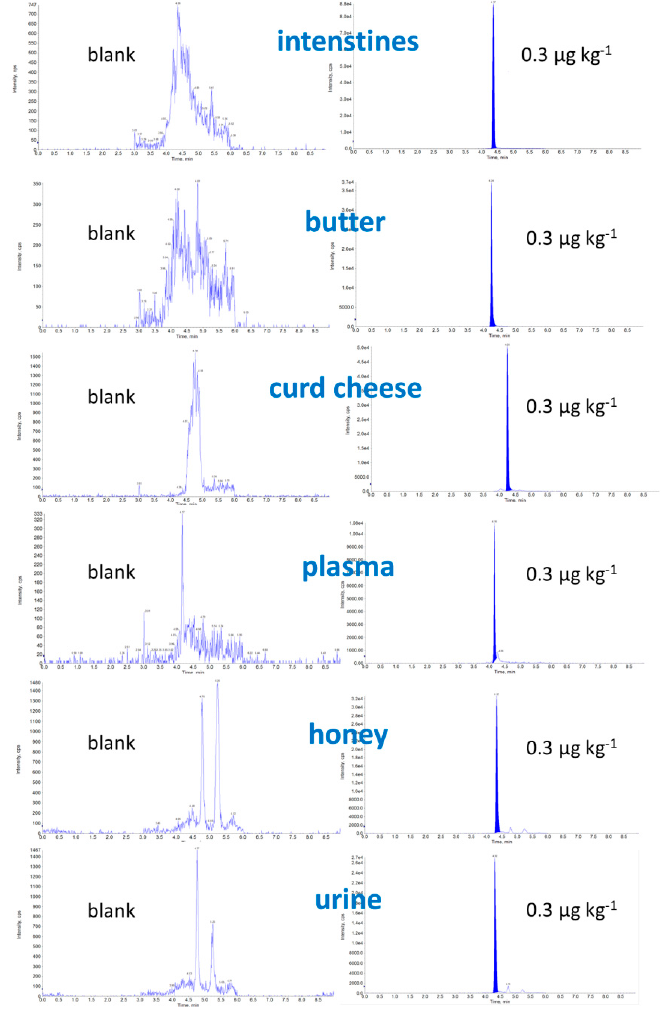
Figure 1. Example of chromatograms, blank and CAP spiked sample (0.3 μ g kg − 1 ).